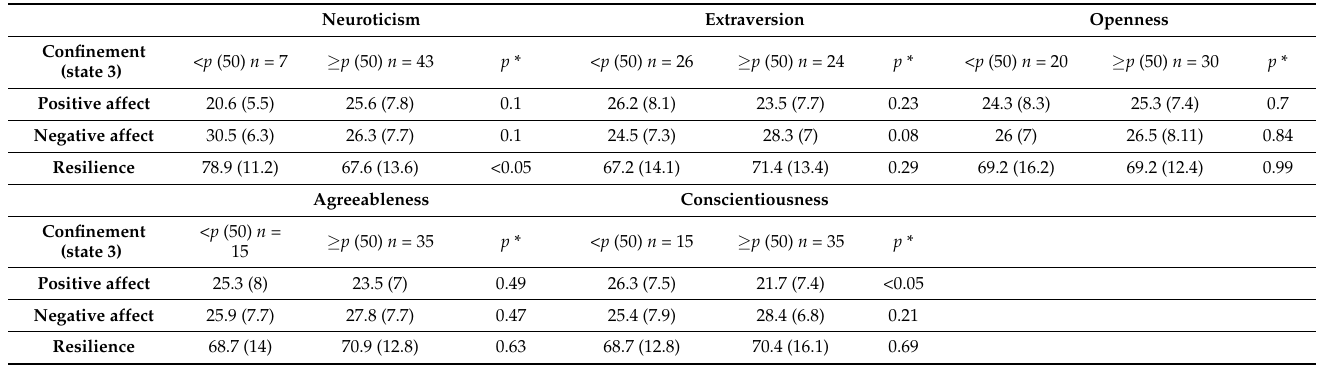
Table 4. Personality profiles according to NEO-FFI in States 1 and 3 result